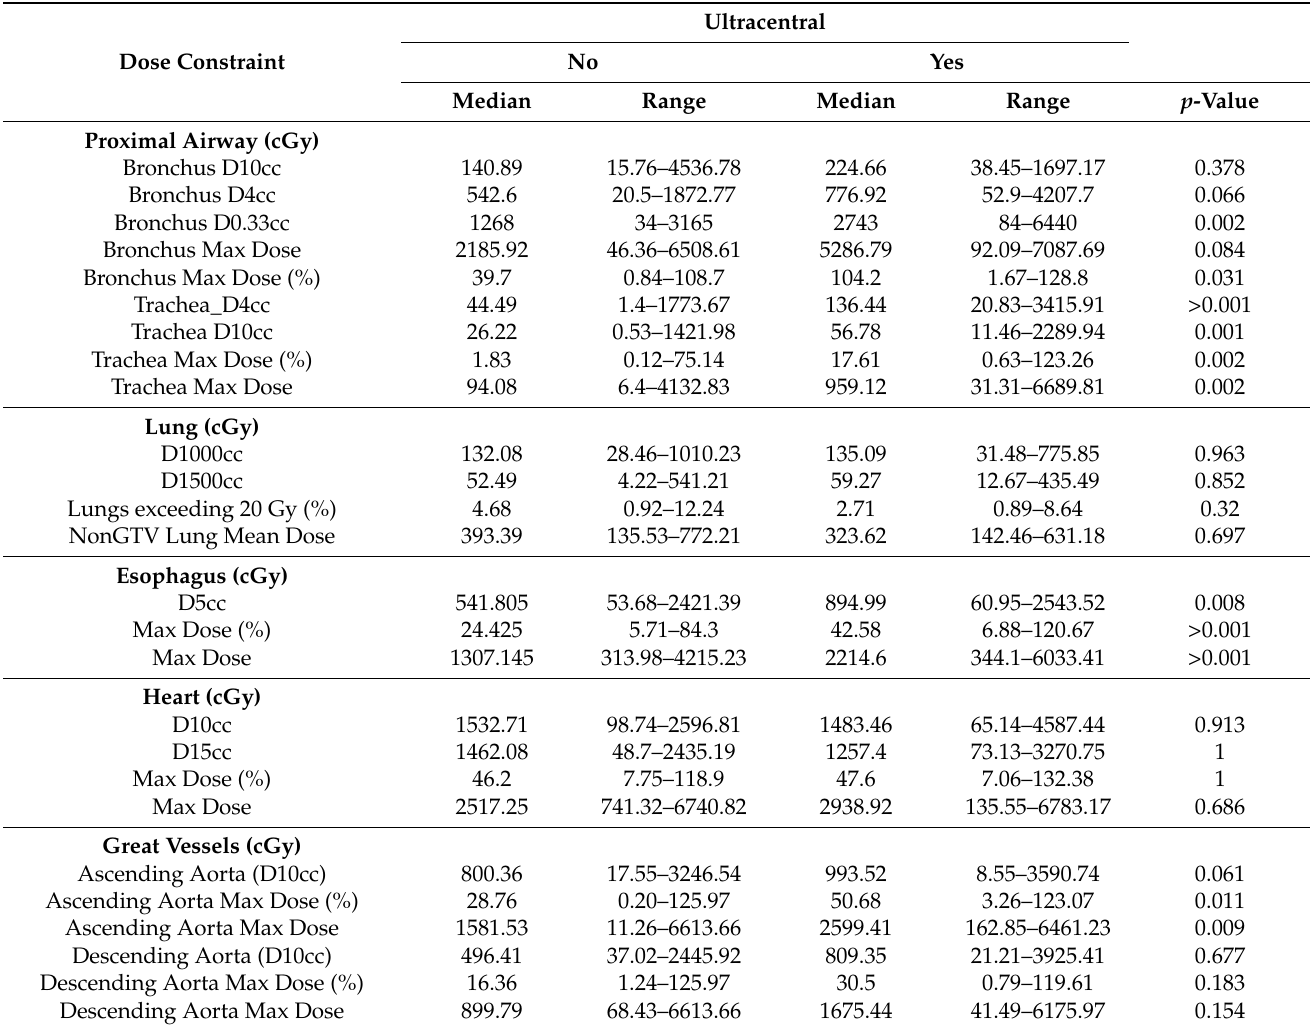
Table 3. Dose to organs at risk in central and ultracentral lung